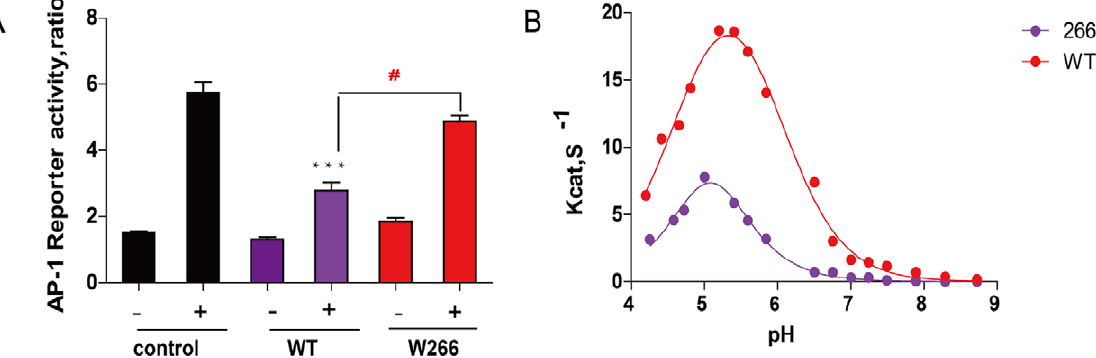
Figure 5. Lyp-W266 variant loses its function in T cell activation and its pH profile of enzyme activity. (A) Comparison of Lyp wild type and W266 variant on TCR-induced AP-1 transcriptional activity. (B) pH-Kcat profile of the pNPP hydrolysis catalyzed by Lyp wild type and R266W mutant.